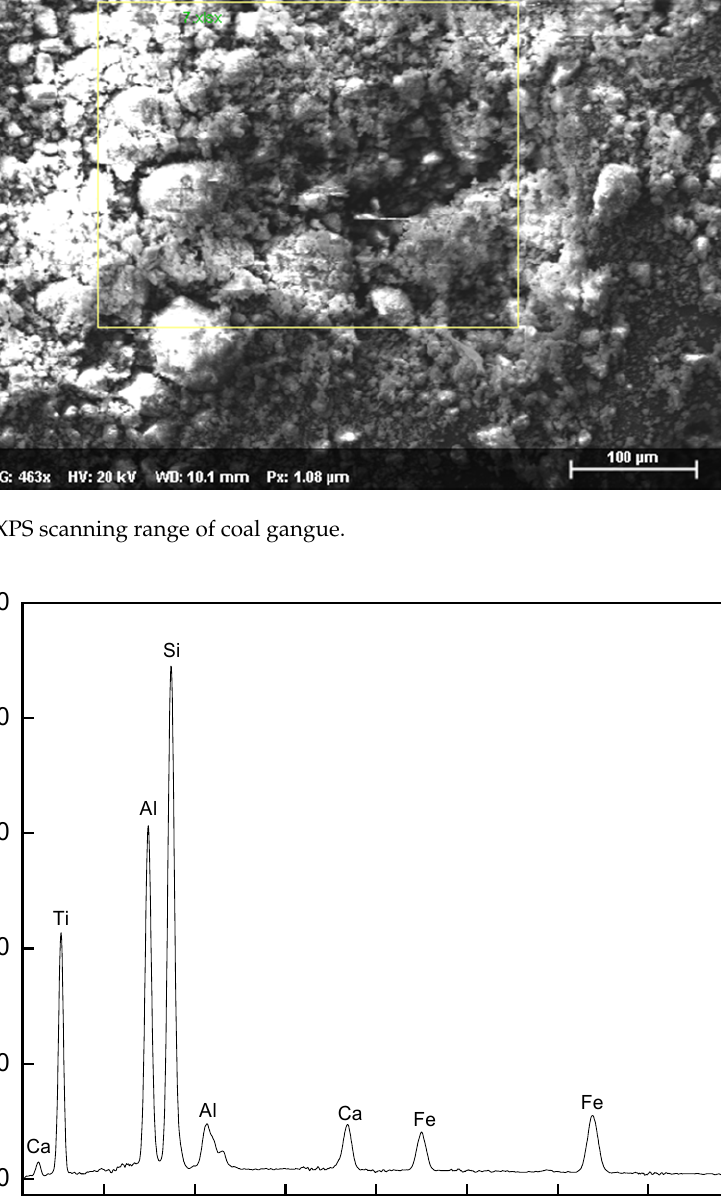
Figure 5. XPS diagram of the coal gangue.